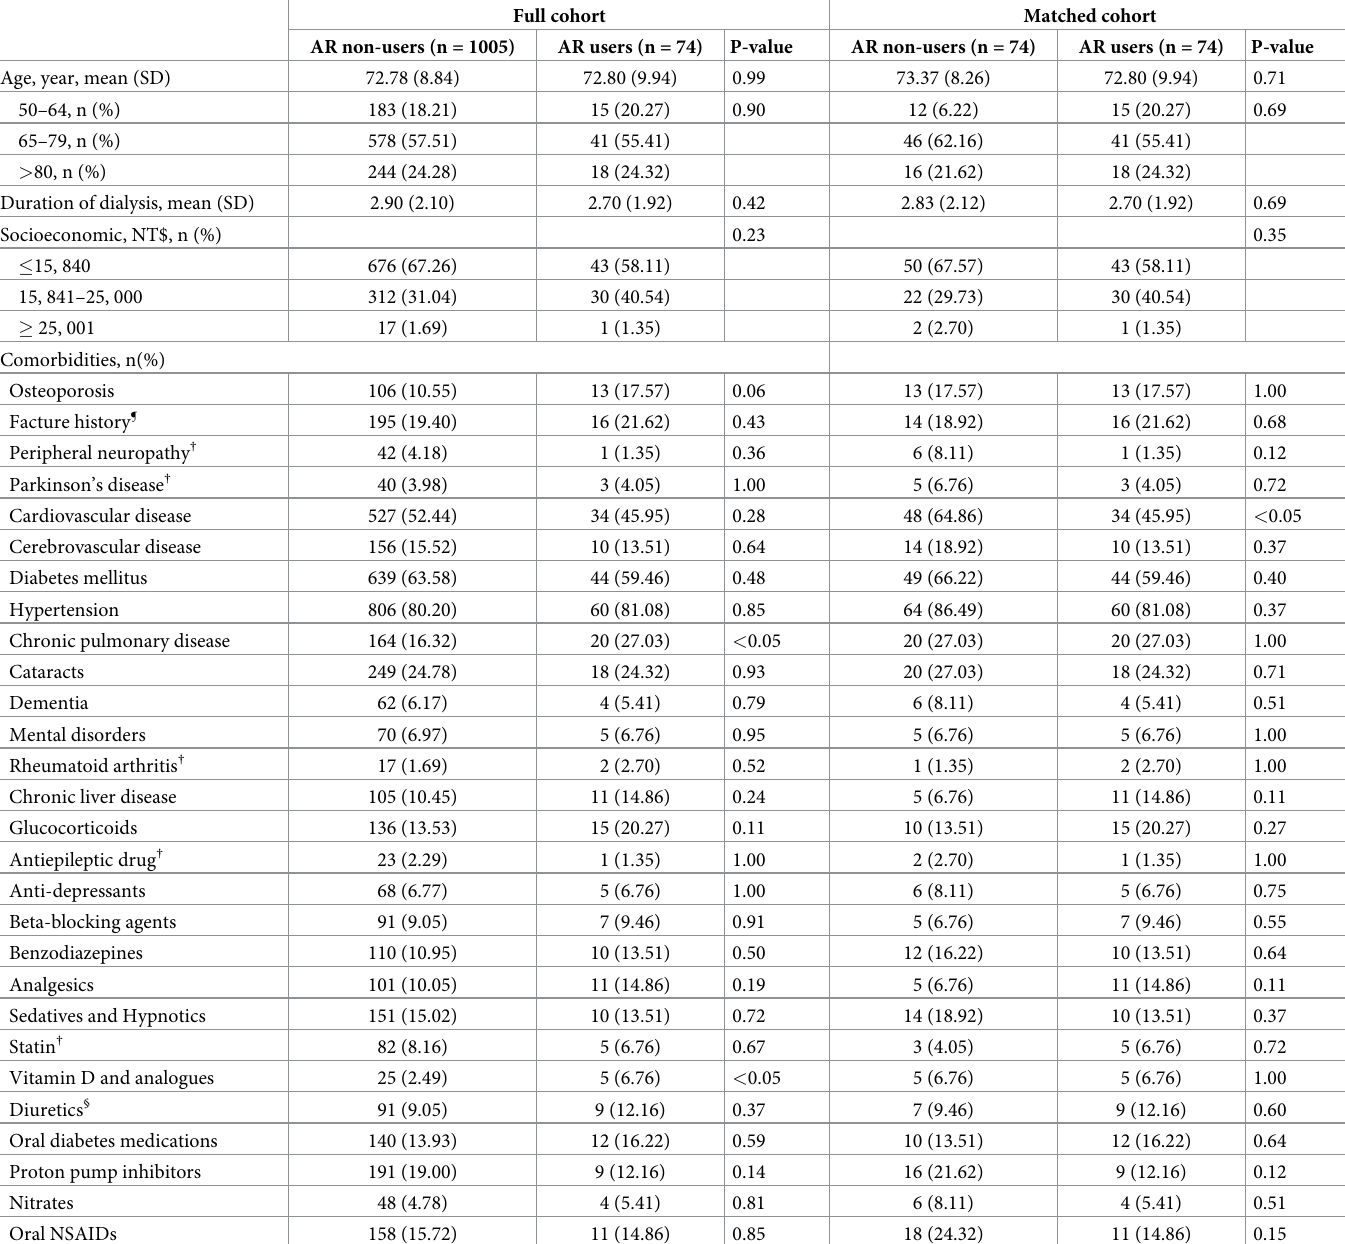
Table 1. Baseline characteristics of AR users and